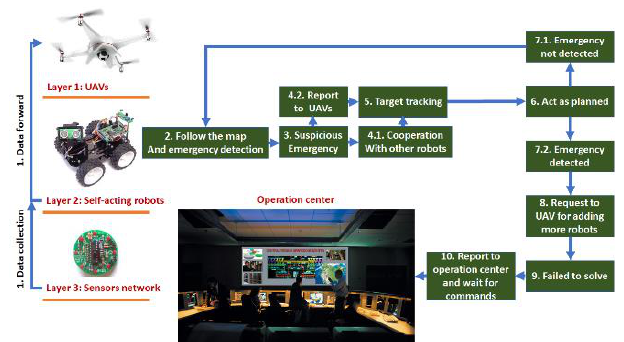
Figure 8 . Information processing steps and actions of